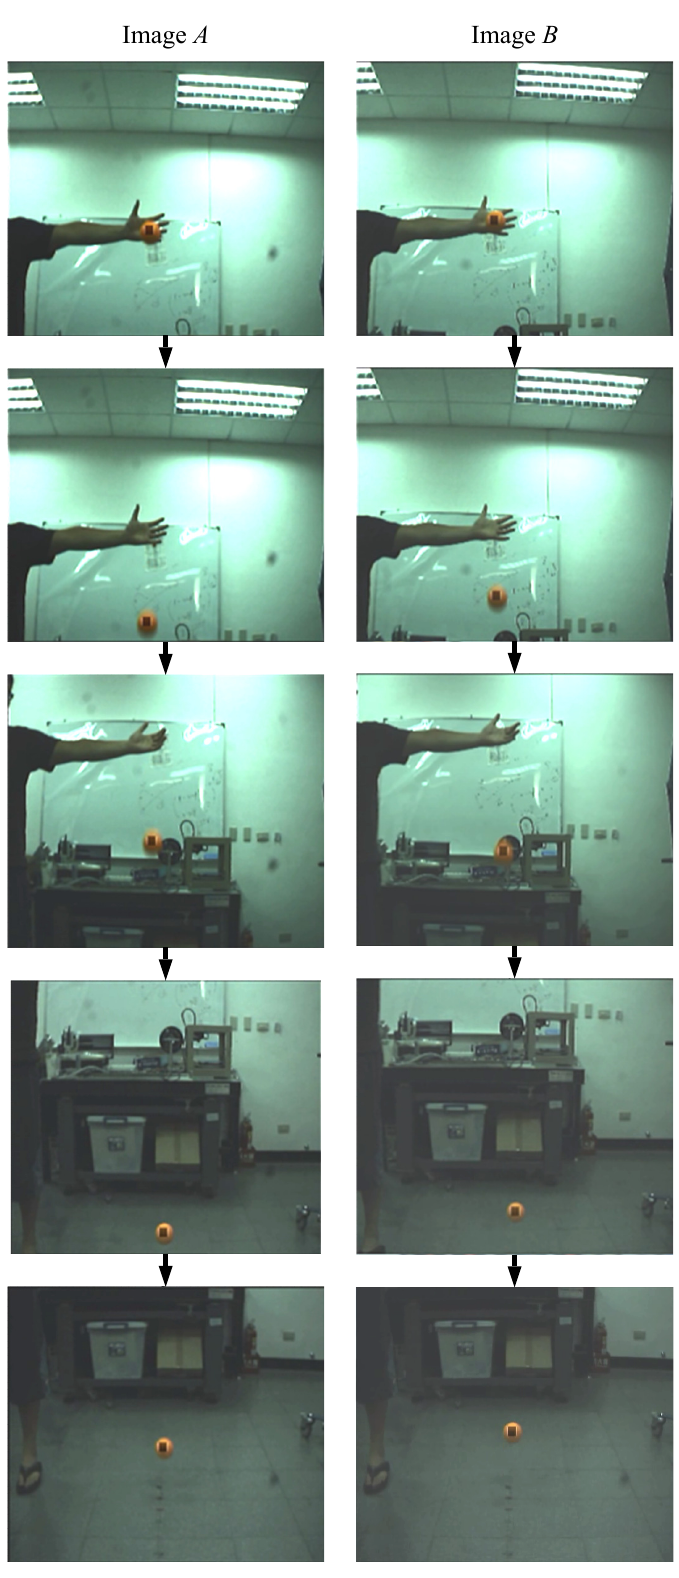
Figure 16. A free falling ball: the sequence of images